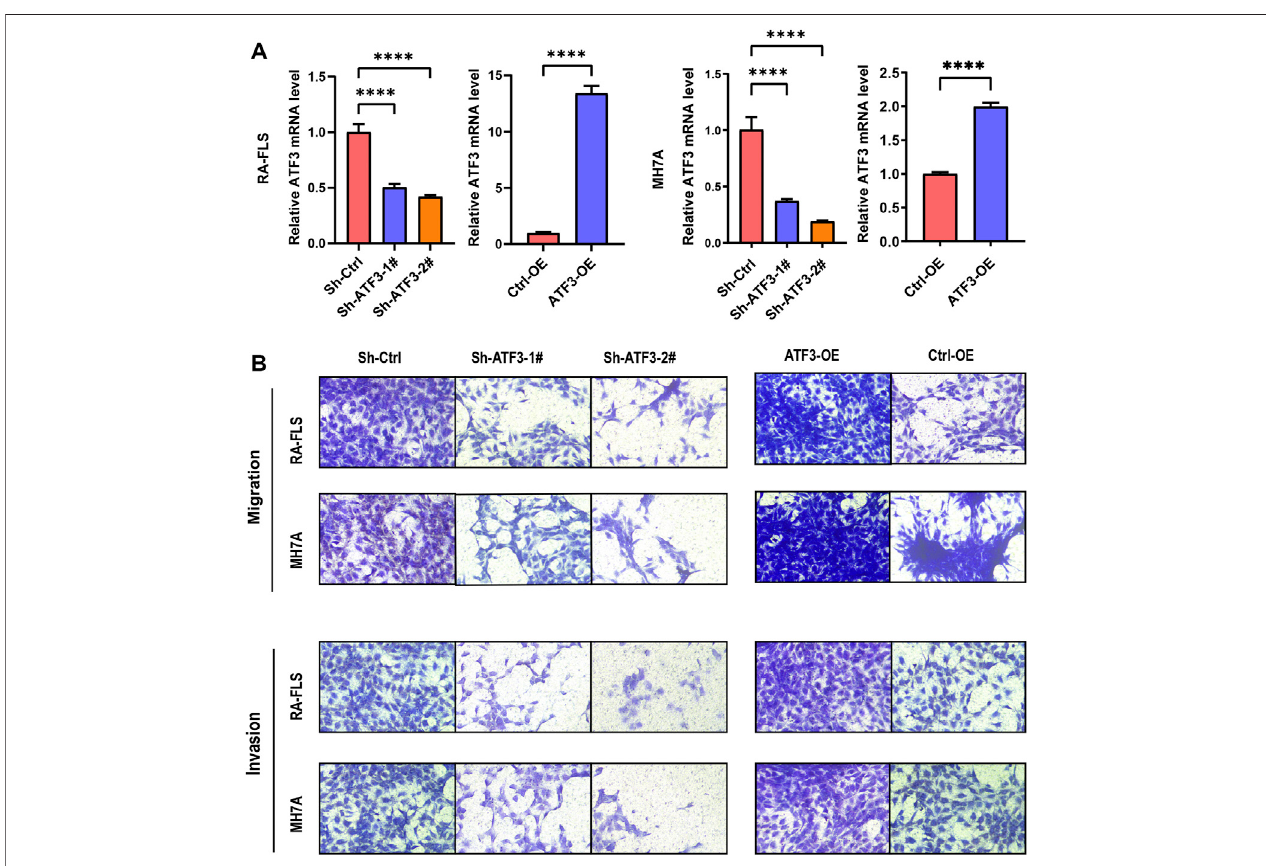
FIGURE 8 | ATF3 could promote cell migration and invasion in rheumatoid arthritis fi broblast-like synoviocyte (RA-FLS) and MH7A. (A) The mRNA of knockdown and overexpressed ATF3 was veri fi ed by qRT-PCR (mean ± SD, n (cid:1) 3). (B) Transwell assay indicated that ATF3 silence decreased the ability of cell migration and invasion,whileATF3overexpressionsigni fi cantlypromotedcellmigrationandinvasioninRA-FLSandMH7A. t -Testwasusedtoanalyzethestatisticaldifference.**** p < 0.0001.